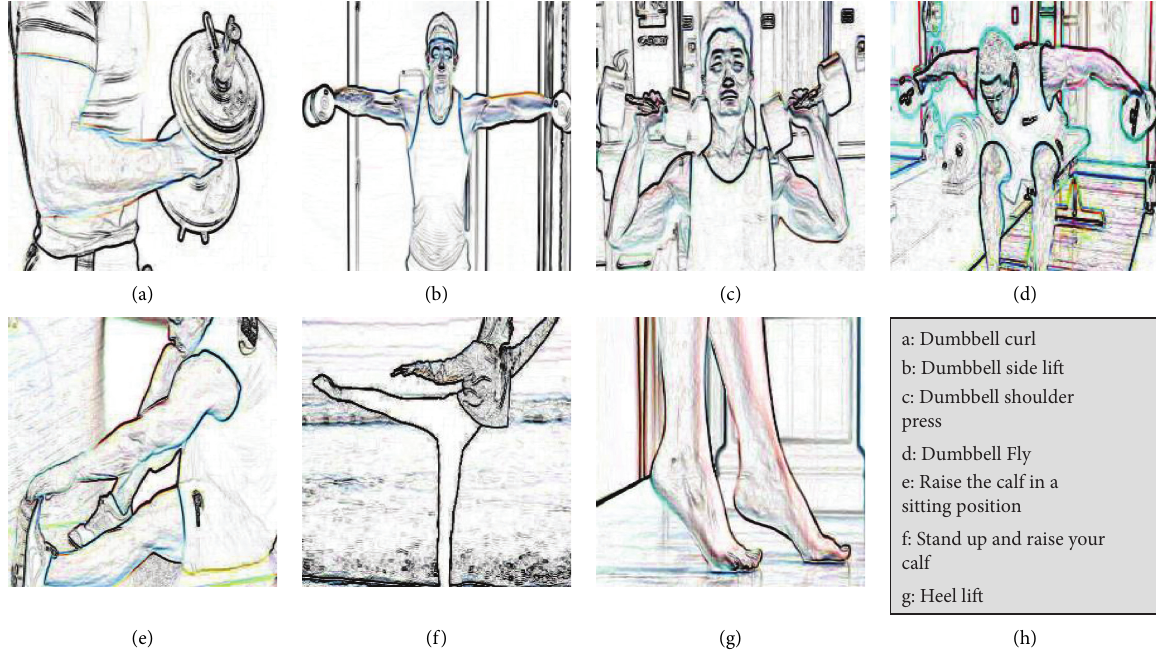
Figure 7: Seven types of body movements not intended. (a) Dumbbell curl. (b) Dumbbell side lift. (c) Dumbbell shoulder press. (d) Dumbbell fly. (e) Raise the calf in a sitting position. (f) Stand up and raise your calf. (g) Heel